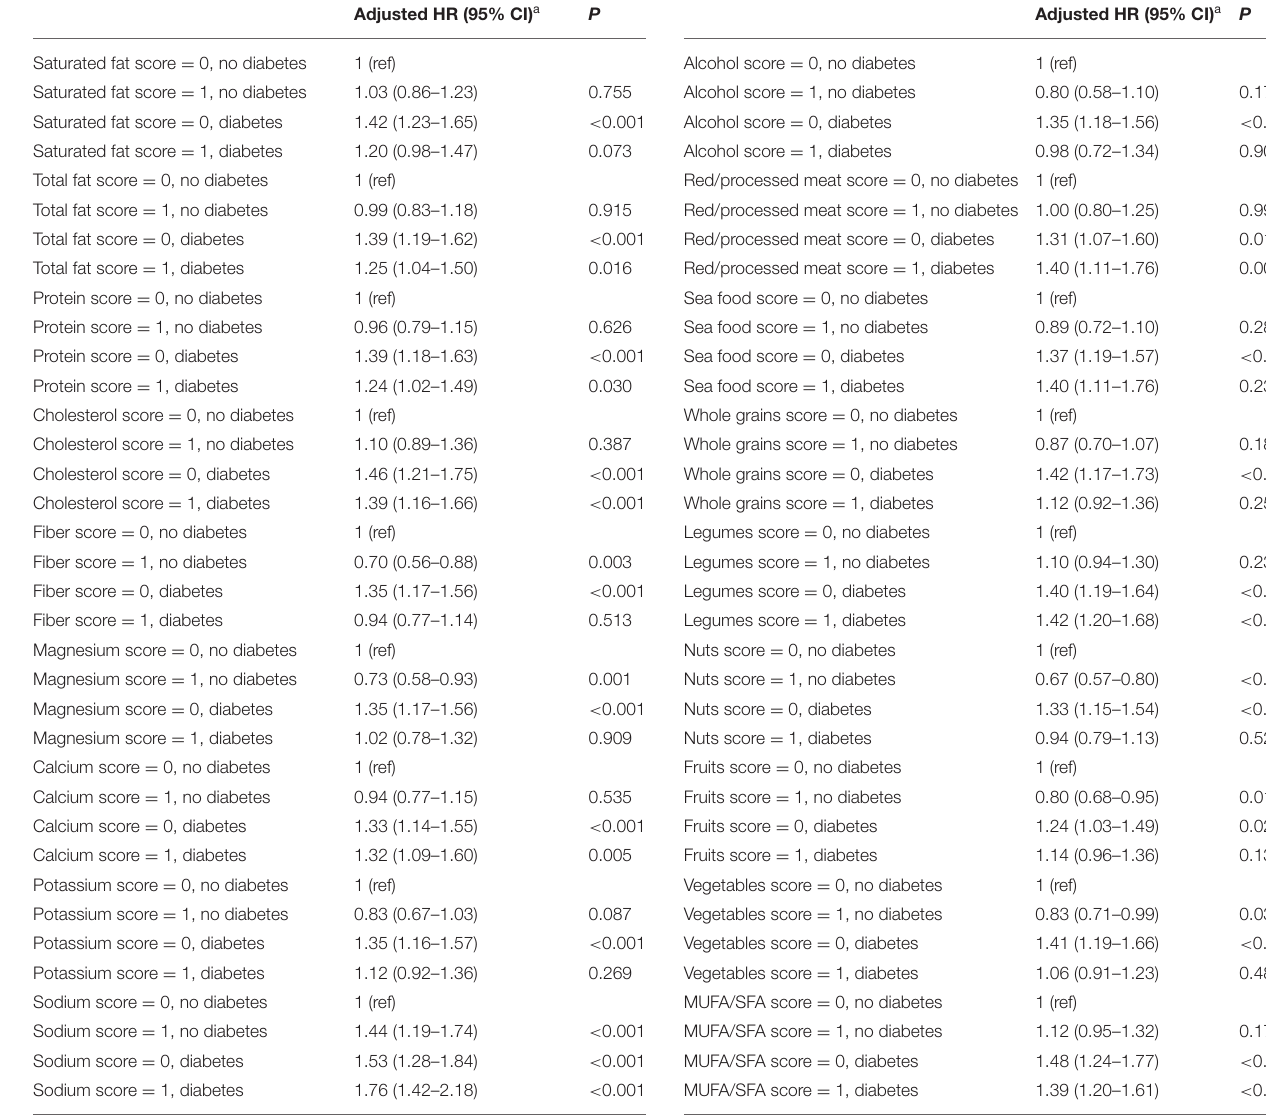
TABLE 6 | Associations of individual components of aMED with all-cause